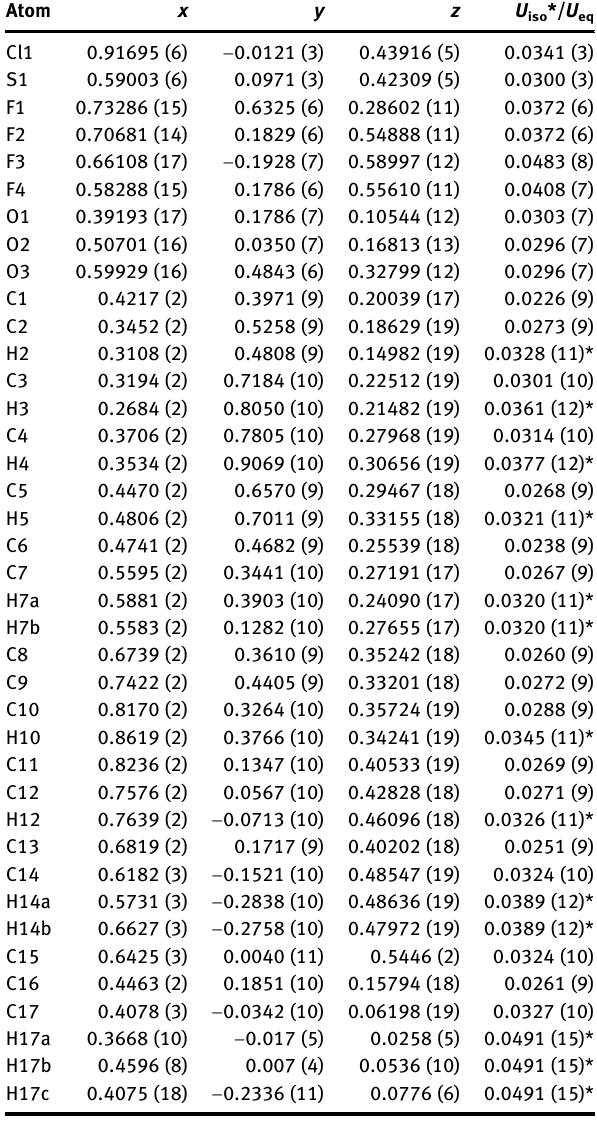
Table  : Fractional atomic coordinates and isotropic or equivalent isotropic displacement parameters (Å 